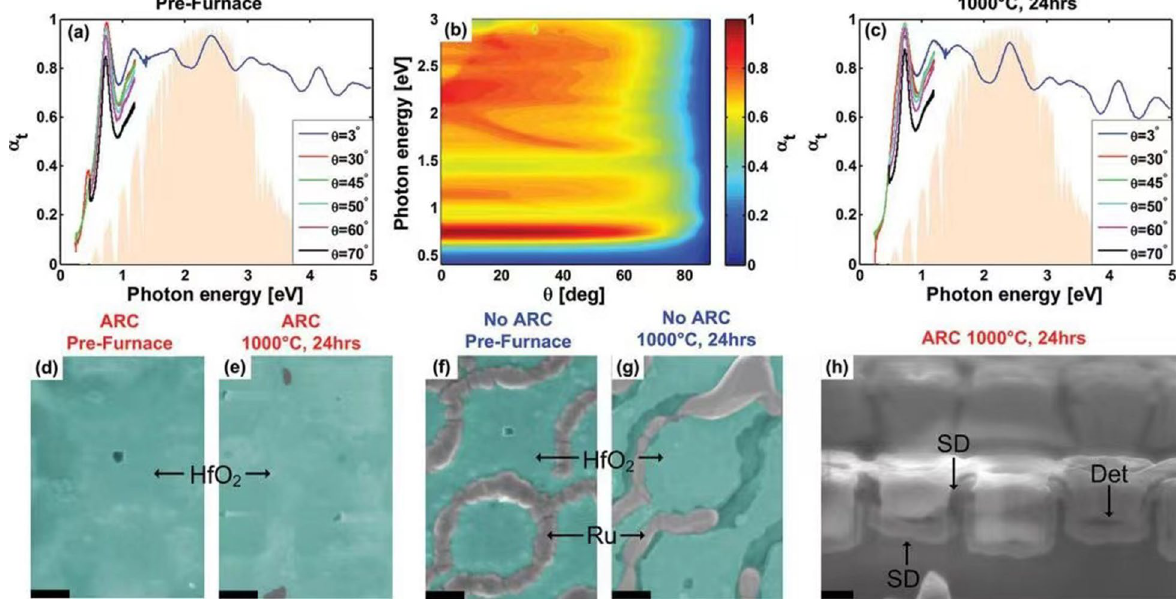
Figure 17 Wide angle high temperature analysis of MDPhC: a Before the furnace test, the absorption spectra of different angles were measured at room temperature; b RCWA simulates the contour plot of the absorption spectrum as a function of incident angle 8; c The absorption spectra of the arc sample stored in a furnace at 1000 ℃ for 24 h correspond to its SEM images obtained d before and e after the furnace test (Note that the ring is no longer visible due to the arc layer); SEM images of non-arc samples f before and g after; h SEM of section FIB of arc sample after furnace test (Degradation caused by metal surface diffusion (SD) and debonding (DET) showed that all scales were 200 nm)